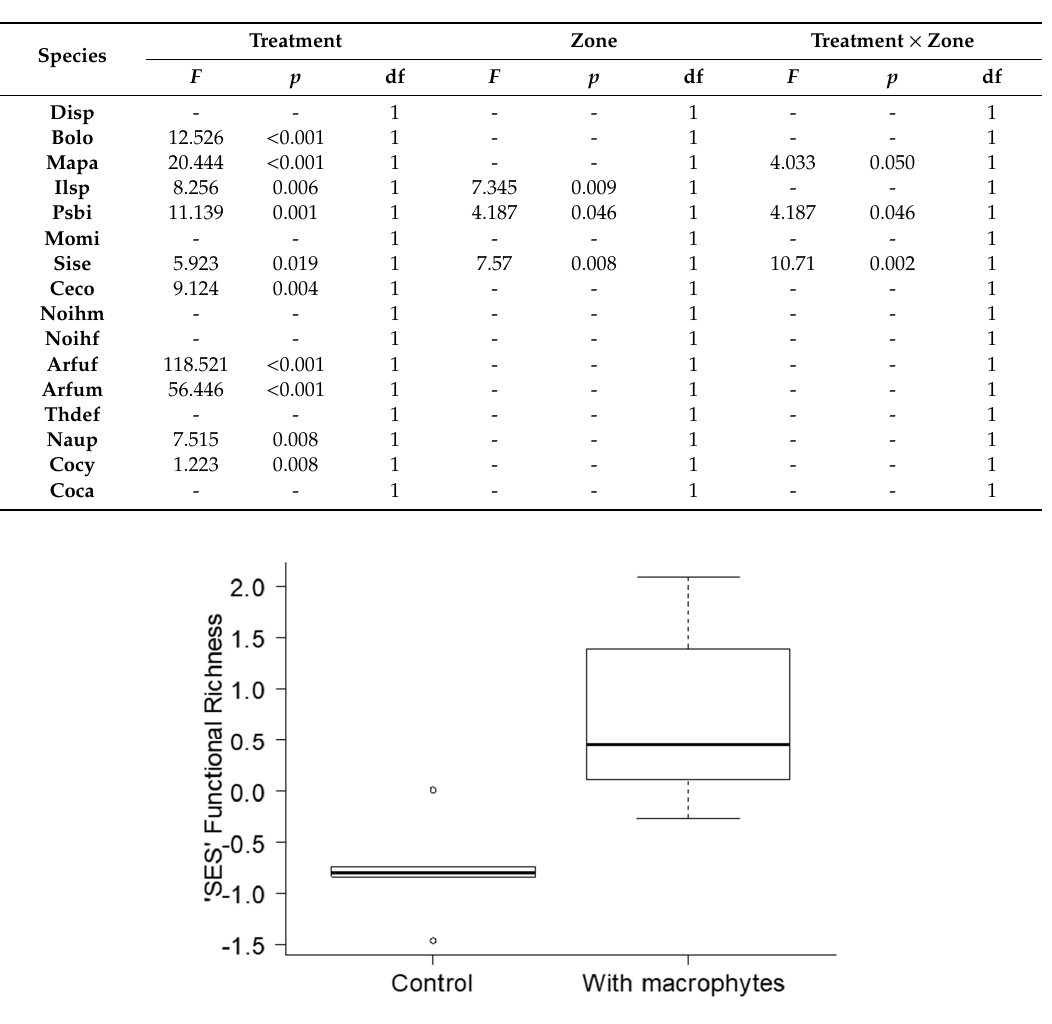
Table 4. Two-way ANOVA results comparing log species density by treatment (with macrophytes and control), by zone (littoral and pelagic), and for the interaction of treatment and zone. Trait abbreviations as in Table 2.